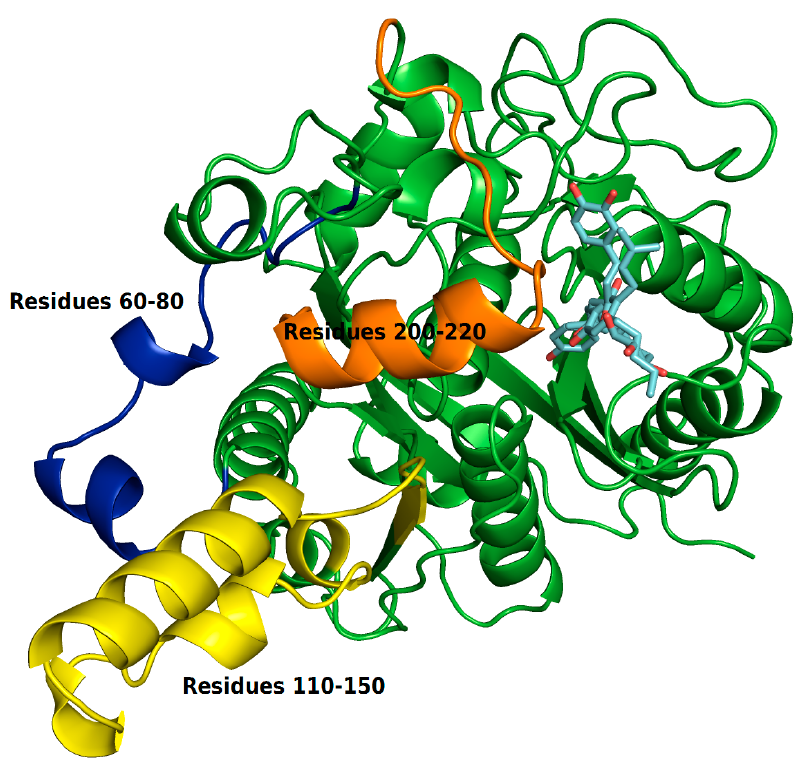
Figure 10. Regions of protein that showed greater residue fluctuations.